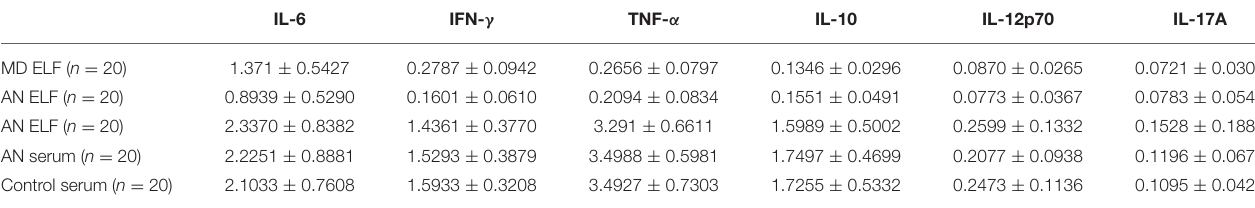
TABLE 1 | Cytokine levels in ES luminal fluid from MD group and AN group, and the serum from MD group, AN group and healthy control group (mean ± SD). IL-6